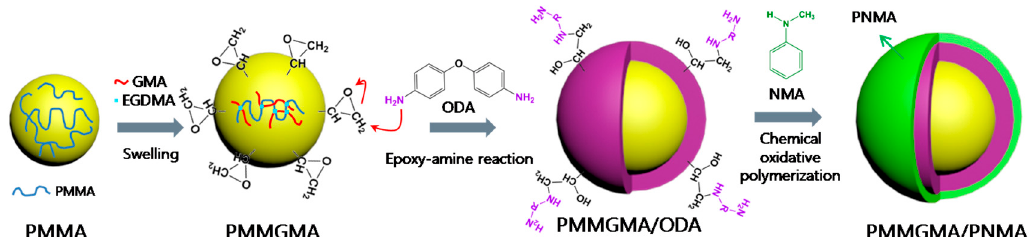
Figure 7. Schematic diagram of fabrication of poly(methyl methacrylate)/poly( N -methylaniline)